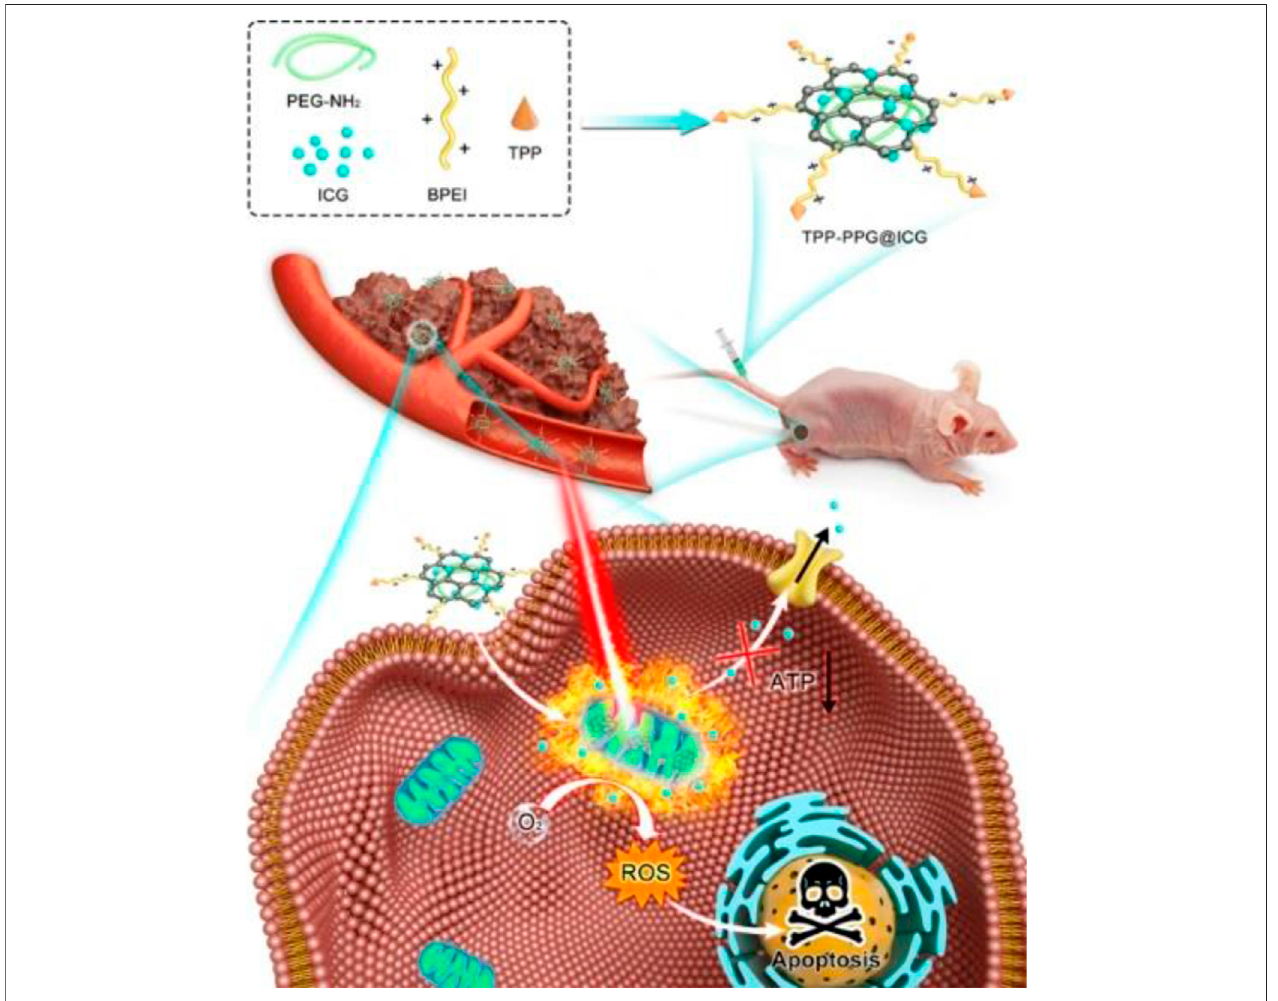
FIGURE 6 | Schematic illustration showing TPP-PPG@ICG nanocomposite targeting mitochondrion for synergistic phototherapy. The PS agent(ICG) wasgrafted onto the PEG- and BPEI-functionalized photothermal agent (NGO) to obtain TPP-PPG@ICG. After cellular internalization, TPP-PPG@ICG accumulated in mitochondria, induced mitochondria-related intrinsic apoptosis, surmounted drug resistance, and enhanced the antitumor ef fi cacy after 808-nm laser irradiation. Reproduced with permission from Zeng et al. (2021).